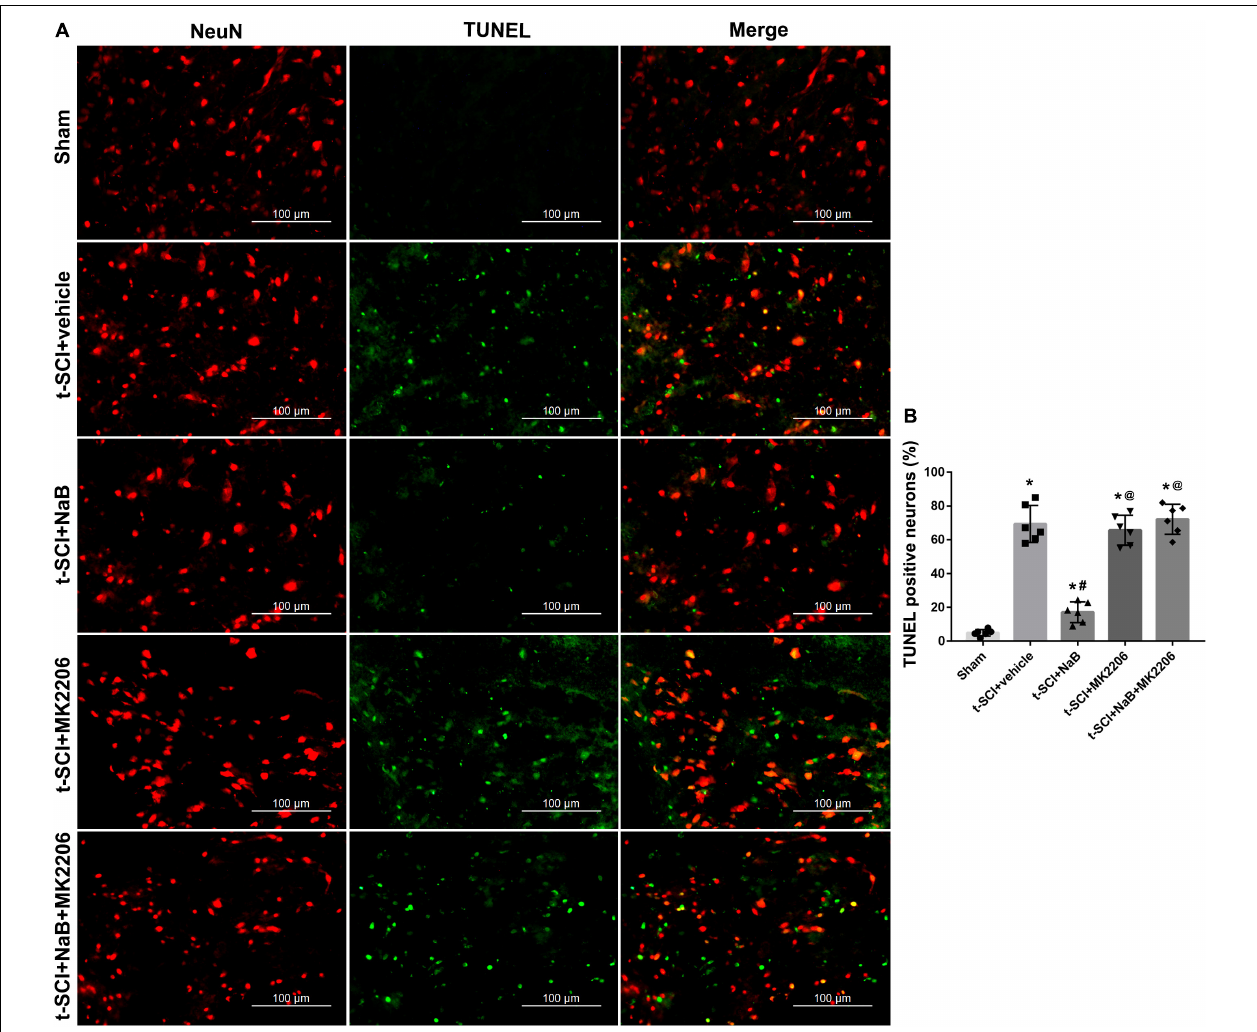
FIGURE 11 | Representative IF staining micrographs showing the proportion of TUNEL-positive neurons in each group at 24 h post-injury. The proportion of TUNEL-positive neurons was significantly increased after t-SCI. NaB treatment significantly decreased the proportion of TUNEL-positive neurons; this effect was reversed by treatment with MK2206. Administration of MK2206 alone did not significantly increase the proportion of TUNEL-positive neurons (A,B) . N = 6 for each group. Data is expressed as mean ± SD and analyzed by one-way ANOVA and Bonferroni’s post hoc multiple comparisons test. ∗ p < 0.05 versus control; # p < 0.05 versus injury; @ p < 0.05 versus injury +